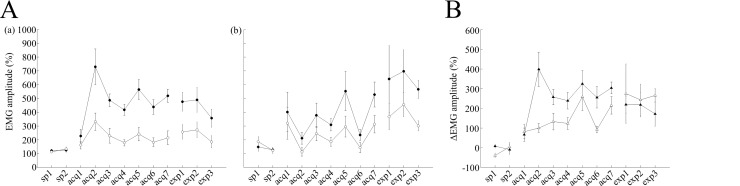
Effects of scopolamine on EMG amplitudes.(A) The left and middle panels represent the averaged EMG amplitude overall valid trials. (a) Averaged data from cued trials (filled circles; n = 8) and non-cued trials (empty circles; n = 8) are illustrated for saline-injected control mice. (b) Averaged data from cued trials (filled circles; n = 8) and non-cued trials (empty circles; n = 8) are shown for scopolamine-injected mice. (B) The right panel represents ΔEMG amplitude values between cued and non-cued trials in both groups. Filled triangles represent ΔEMG amplitude values for the saline-treated group and empty triangles represent ΔEMG amplitude values for scopolamine–treated mice. In panel A, the vertical axis represents averaged EMG amplitudes, while the horizontal axis illustrates corresponding sessions, and the vertical bars indicate the standard error of the mean. In panel B, the vertical axis represents the ΔEMG amplitude values, while the horizontal axis illustrates corresponding sessions and the vertical bars indicate the standard error of the mean.